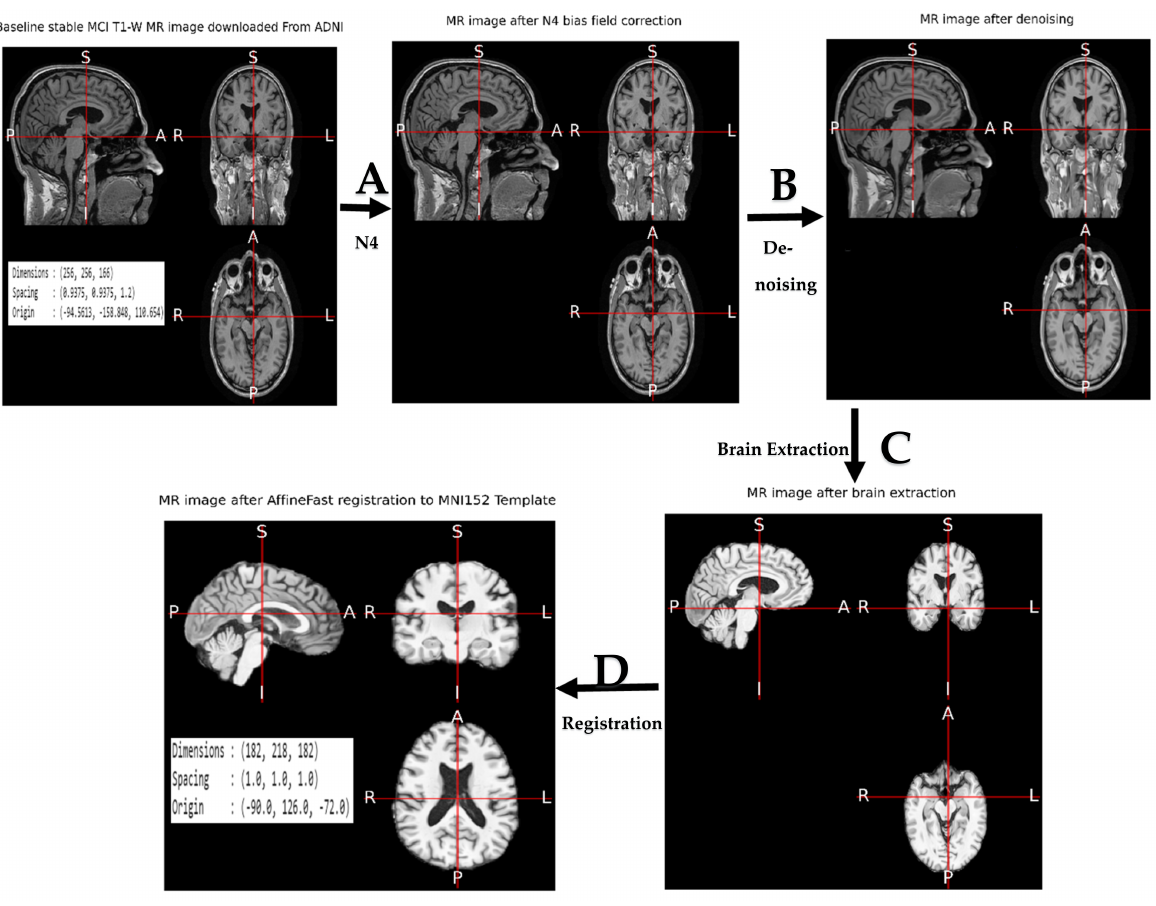
Figure 2. This illustration shows an example of sMCI MR image preprocessing implemented in our study. The original MR picture dimensions were 256 × 256 × 166, but the output MRI dimensions were altered to 182 × 218 × 182. The actions listed were performed in sequence. ( A ) N4 bias field correction, ( B ) denoising, ( C ) 3D U-Net used for brain extraction, ( D ) affine fast registration in the MNI152